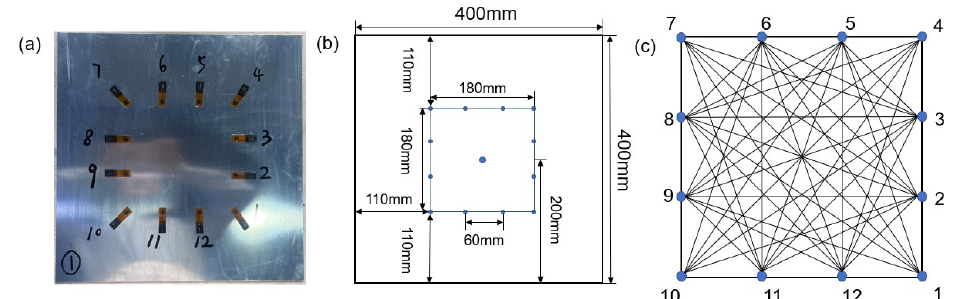
Figure 2. Designs ( a ) Test specimen. ( b ) Specimen diagram. ( c ) The layout of piezoelectric transducers network.